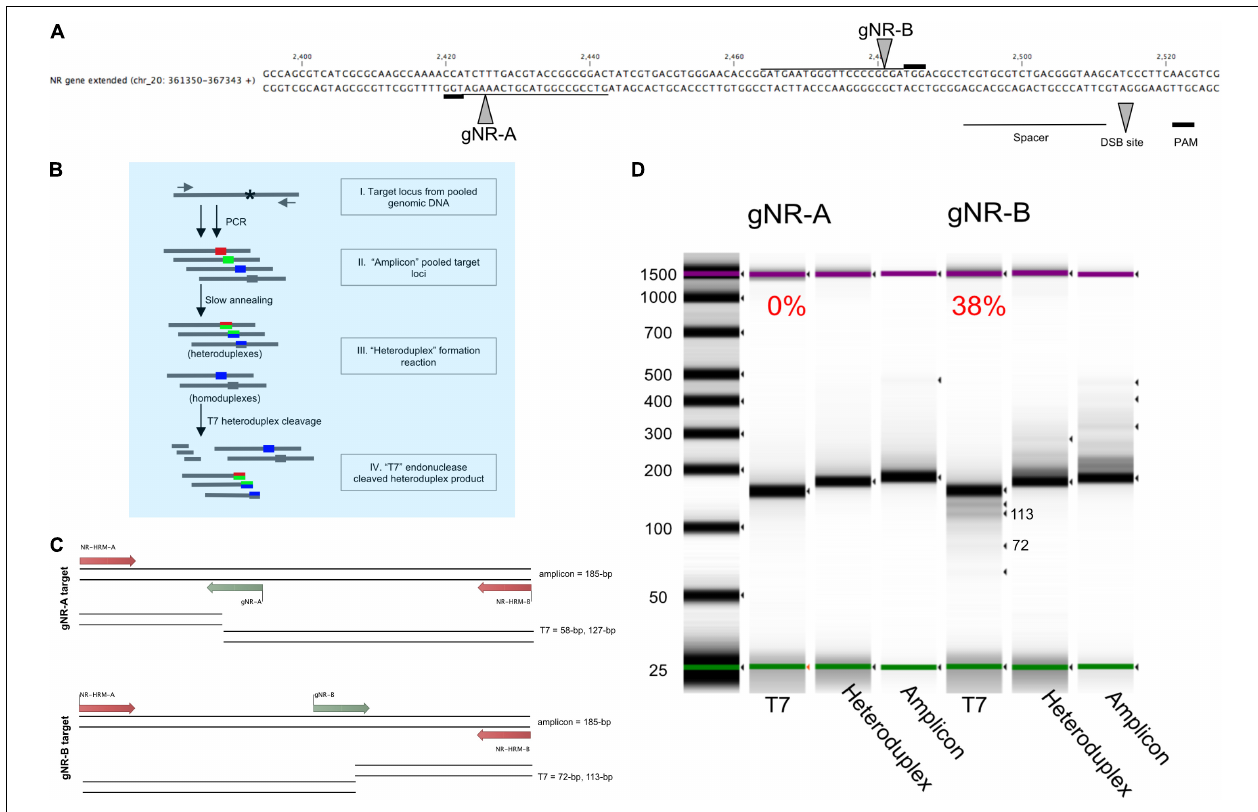
FIGURE 2 | Pooled-diatom transformant T7 assay screen for in vivo Cas9 activity to compare the mutagenesis efficiency between two sgRNAs designed to target the nitrate reductase (Phatr3_J54983) gene. (A) Two sgRNAs were designed within the Phaeodactylum genomic region displayed. The spacer sequence (line), PAM site (bold line) and Cas9 cut site (grew arrow) are defined for sgRNA gNR-A and gNR-B. (B) The T7 heteroduplex assay was used to quantify the efficiency of in vivo Cas9 activity for each sgRNA for a population of pooled- Phaeodactylum transformants. This chart demonstrates how the T7 heteroduplex assay can produce and cleave mismatched amplicon products(I). The pool of target loci amplicons (II) is denatured and slowly annealed to form mismatched double-stranded DNA, or heteroduplexes (III). The heteroduplexes are then digested by T7 endonuclease I (New England Biolabs). Heteroduplexes are subsequently cleaved by T7 while homoduplexes remain full length. (C) The expected T7 cleavage pattern for gNR-A and gNR-B associated amplicons. The size of the “amplicon” input is 185-bp. For gNR-A, the expected “T7” products are ∼ 185-bp (homoduplex), 127-bp and 58-bp. For gNR-B, ∼ 185-bp (homoduplex), 113-bp and 72-bp. (D) The three products, “amplicon,” “heteroduplex,” and “T7” were size analyzed on a 4200 TapeStation System (Agilent, Santa Clara, CA, United States). The T7 cleavage efficiency is displayed above each “T7” lane in the gel that represents the mutagenesis efficiency of each sgRNA for all Phaeodactylum cell lines. Each band detected by the software is indicated by a black arrow. The expected “T7” 113-bp and 72-bp bands are